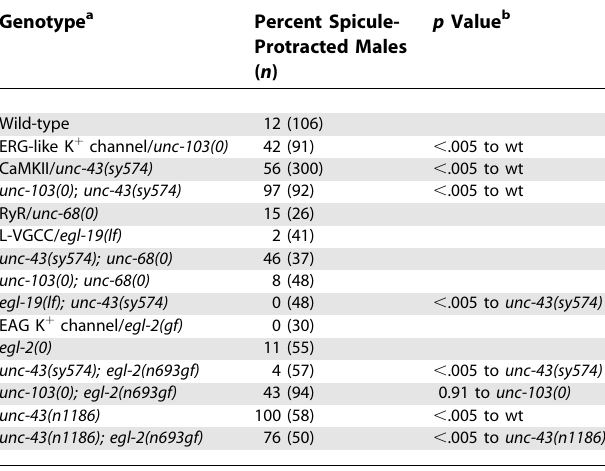
Table 1. Abnormal Spicule Protraction Induced by Mutant CaMKII/ unc-43 and ERG-Like K þ Channel/ unc-103 Alleles Genotype